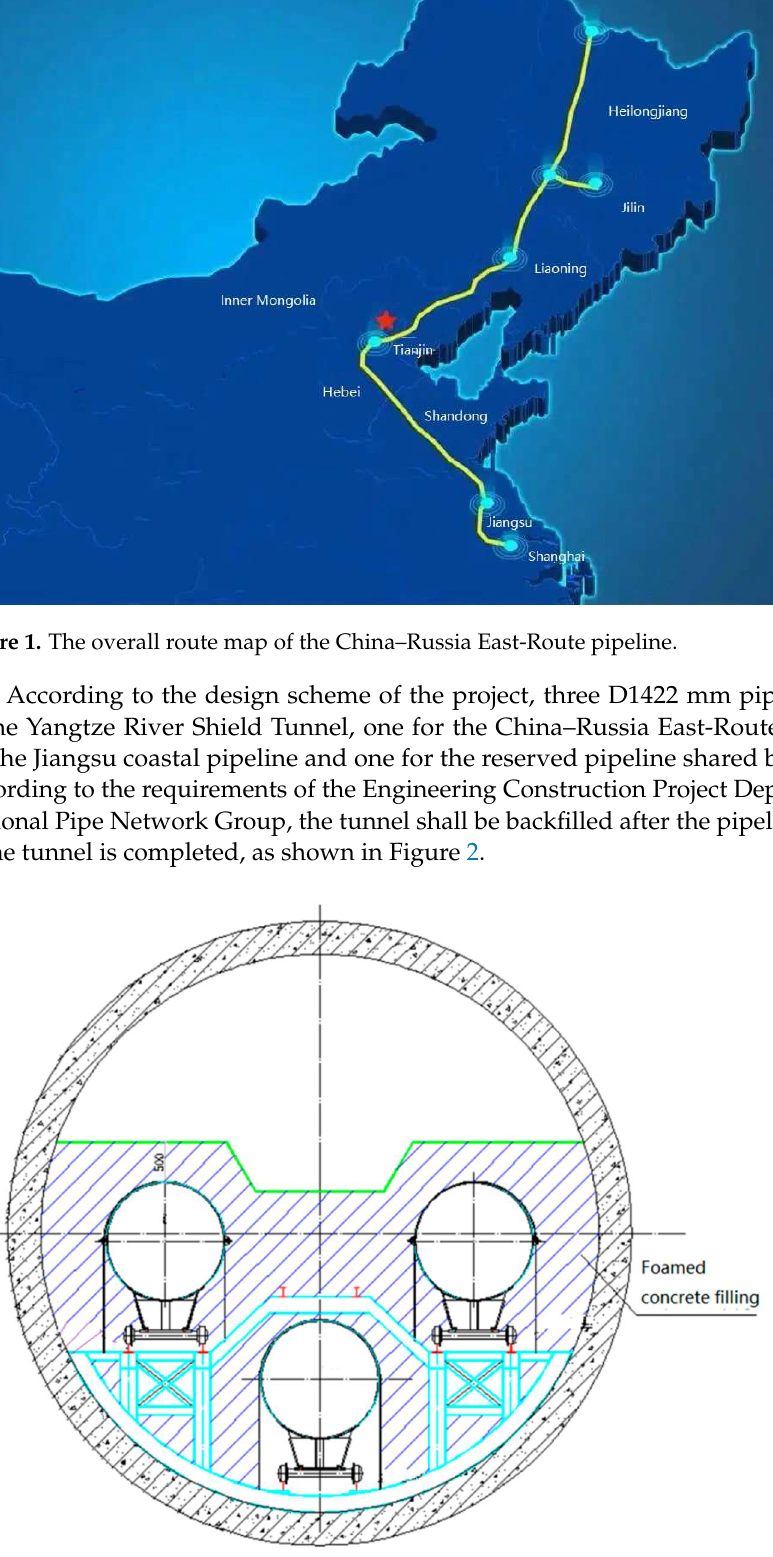
Figure 2. Schematic diagram of foamed-concrete tunnel filling. The common backfilling methods for gas-pipeline tunnels include water backfilling, air backfilling and foamed-concrete backfilling. Water backfilling is widely used due to